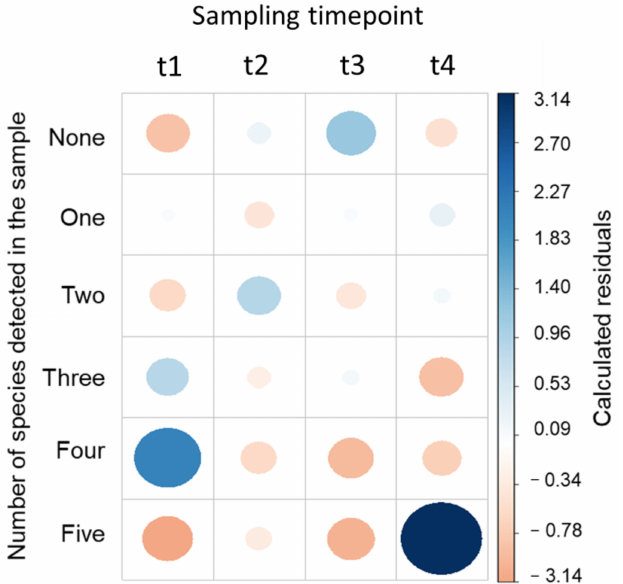
Figure 3. Plot of chi-square residuals (correlation coefficient) for the bacterial associations found at different sampling time points (t1—before gold fiducial implantation; t2—before radiotherapy; t3—at the end of the RT; t4—1 month after radiotherapy). The color and circle size refer to the degree of correlation coefficient. Blue color refers to the positive correlation, while red color refers to negative